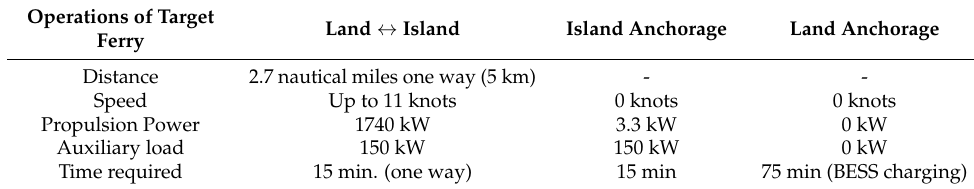
Table 2. Target ferry operation profile.